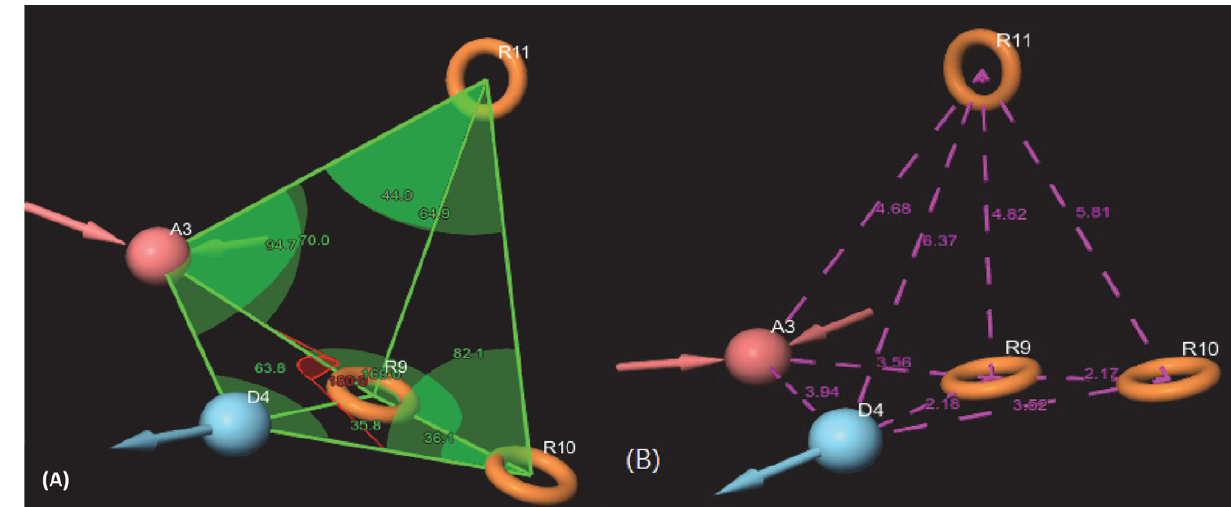
Fig. 2. (A) Pharmacophore model ADRRR1 interstice angles in (°) unit between the pharmacophoric points and ( B) Pharmacophore model ADRRR1 interstice distances in Å unit.